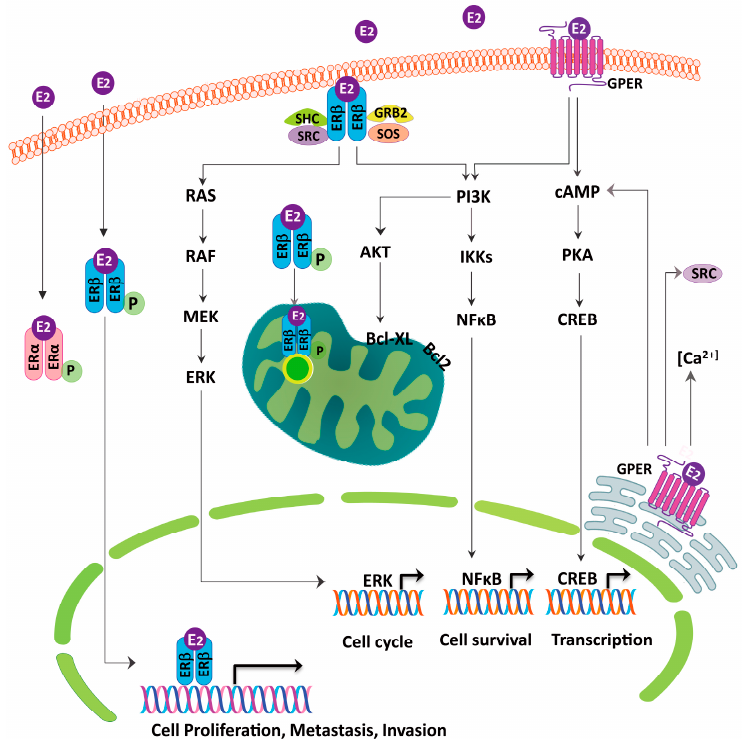
Figure 2. The putative role of the estrogen receptor in regulating the lung cancer cells growth. The estrogen receptor β (ER β ) appears to be the predominant form in lung cancer and is present in the cytoplasm, nucleus, mitochondria and plasma membrane. The ER β has been found to activate the PI3K/IKK/NF κ B, PI3K/AKT/Bcl-XL and the RAS/RAF/MEK/ERK signaling pathways to regulate the cell proliferation, invasion, metastasis, mitochondrial biogenesis and anti-apoptosis. The G-protein- coupled estrogen receptor (GPER) activates the cAMP/PKA/CREB and the PI3K/IKK/NF κ B signaling pathways and acts as a modulator of the neoplastic transformation.